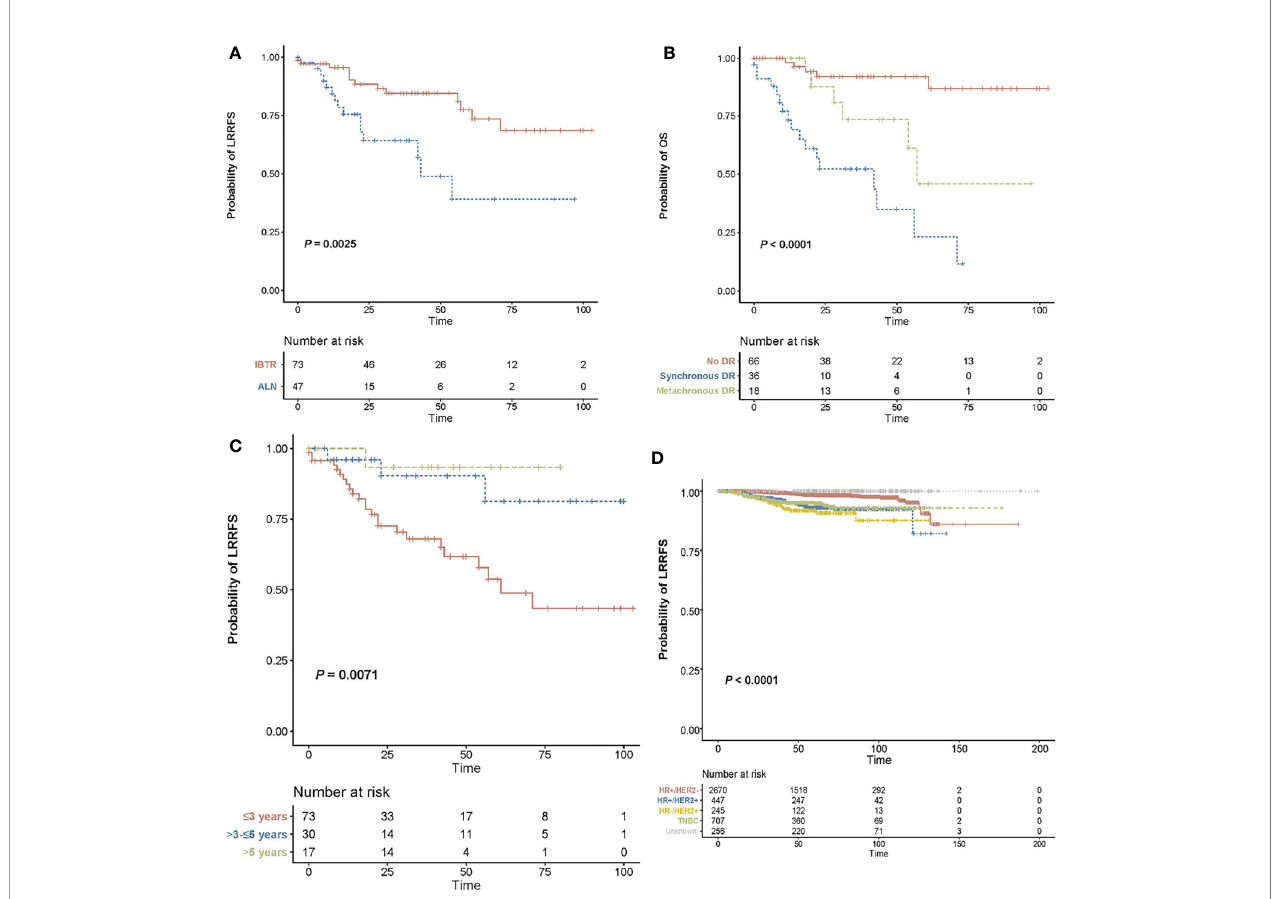
FIGURE 3 | Overall survival curves after lumpectomy. (A) Kaplan-Meier curves for overall survival in patients with (either as synchronous or subsequent failures) and without distant recurrence in the setting of loco-regional recurrence. (B) Kaplan-Meier curves for overall survival based on recurrence type. (C) Kaplan-Meier curves for overall survival according to recurrence-free interval. (D) Kaplan-Meier curves for loco-regional recurrence-free survival speci fi ed by molecular subtype. ]OS, overall survival; LRRFS, loco-regional recurrence-free survival; DR, distant recurrence; IBTR, ipsilateral breast tumor recurrence; RNR, regional nodal recurrence.